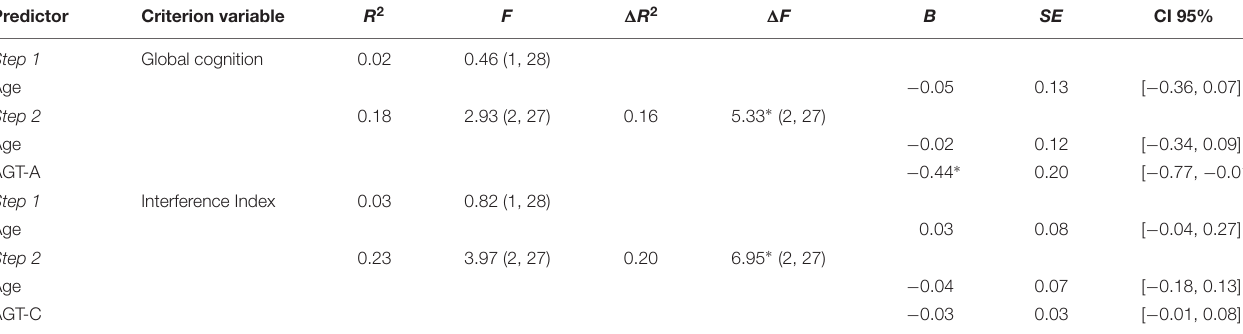
TABLE 3 | Summary of the Bootstrapped Hierarchical Regression Analysis when predicting global cognition and interference index.